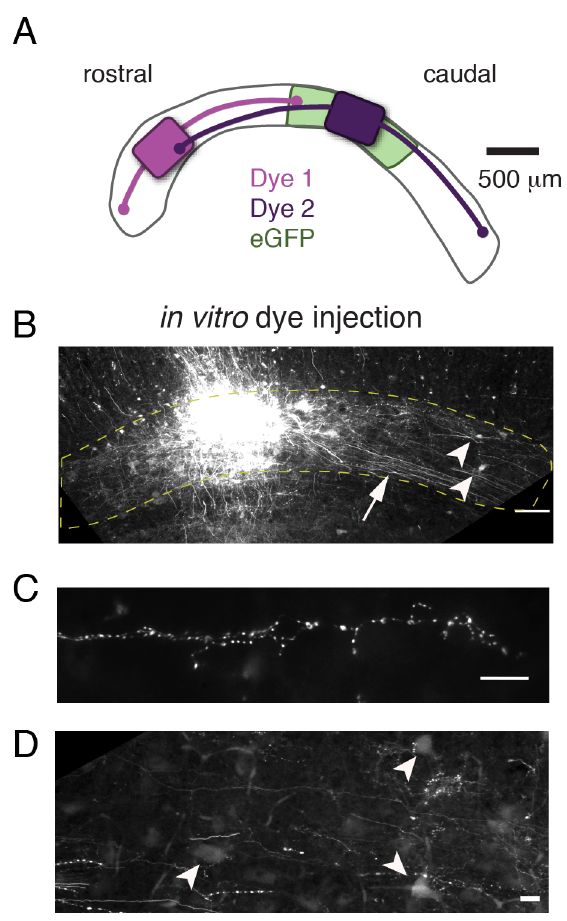
Figure 5. Invitro labeling of long-range axonal projections and somata in the horizontal plane. A) Schematic showing the locations of injections of fluororuby dye (purple and lavender) along with approximate distances of observed axonal projections (curved lines). Light green shading indicates location of eGFP injection shown in Fig. 4 for context; virus and fluororuby injections were not performed in the same tissue. B) Low power image of the Imc, cut in the horizontal plane, following an injection of fluororuby. Horizontally oriented axons (arrow) can be observed streaming from the injection site. Retrogradely labeled somata are apparent away from the injection site (arrowheads). Scale bar =100 m m. C) High power image of labeled axons, distant from the dye injection site. Boutons can be observed along the axon. Scale bar =10 m m. D) High power image of retrogradely labeled somata (arrowheads), distant from the dye injection site. Scale bar =10 m